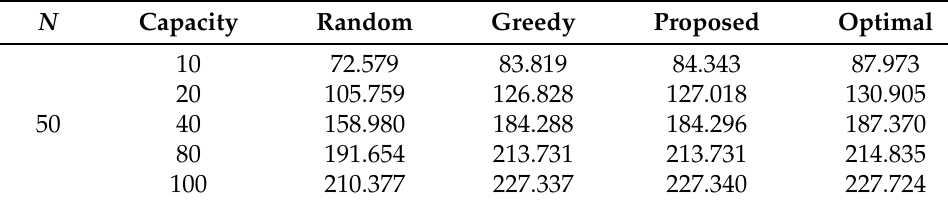
Table 10. Average profit of selected items per capacity in RI.